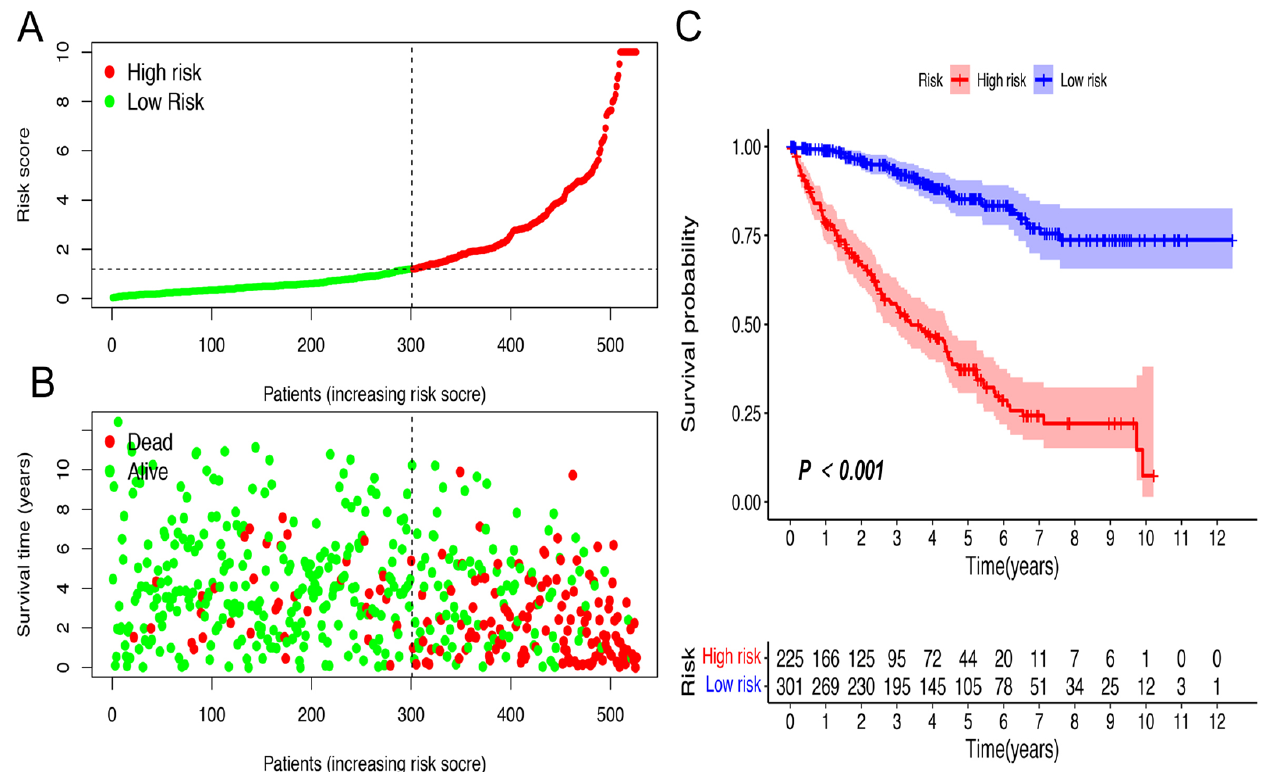
Figure 3. Risk assessment model for predicting prognosis. ( A ) Risk score; ( B ) survival outcome; ( C ) patients. Patients in the low-risk group experienced a longer survival time, as demonstrated by the Kaplan–Meier test.